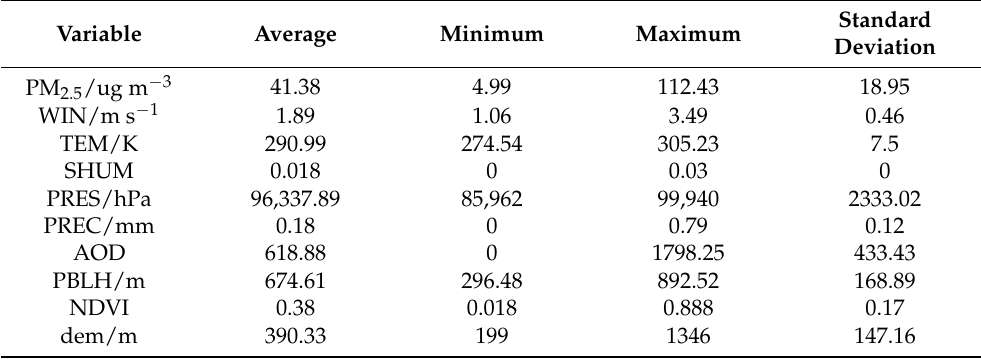
Table 6. Statistical results of the natural environment